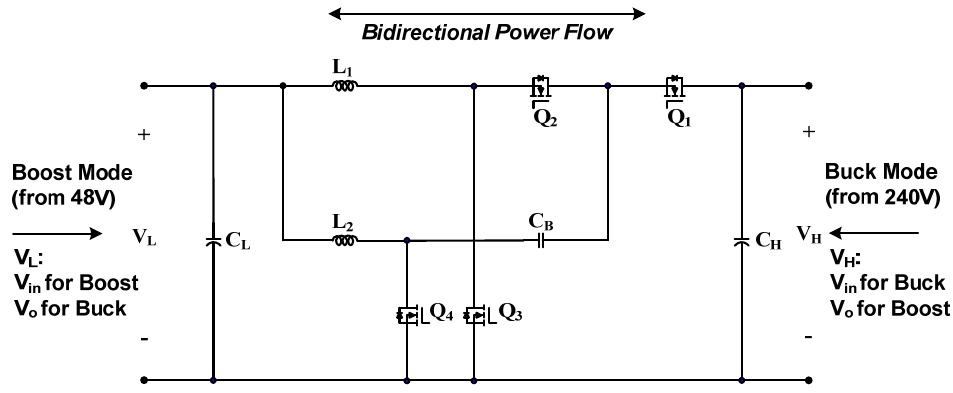
Figure 2. Proposed two-phase interleaved bidirectional DC/DC converter topology.